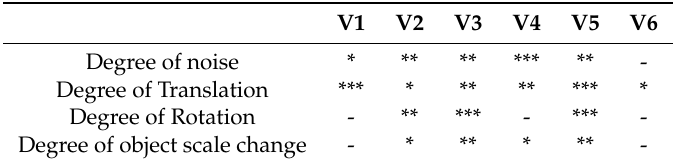
Table 2. Summary of different alterations imposed for each video. The degree of noise signifies the number of FPs outside of the shape contour of the desired object (due to noise or a table border). The number of “*” corresponds to the degree of noise, object translation, rotation or scale change; the more the stars “*” are, the more the image is